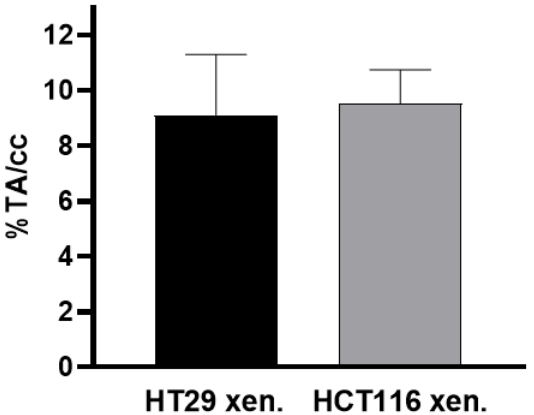
Figure 5. Accumulation of 2-[ 18 F]FDG in xenografts derived from HT29 and HCT116 cells. Data are depicted as %TA/cc and presented as mean ± SD ( n ≥ 3 per xenograft model).